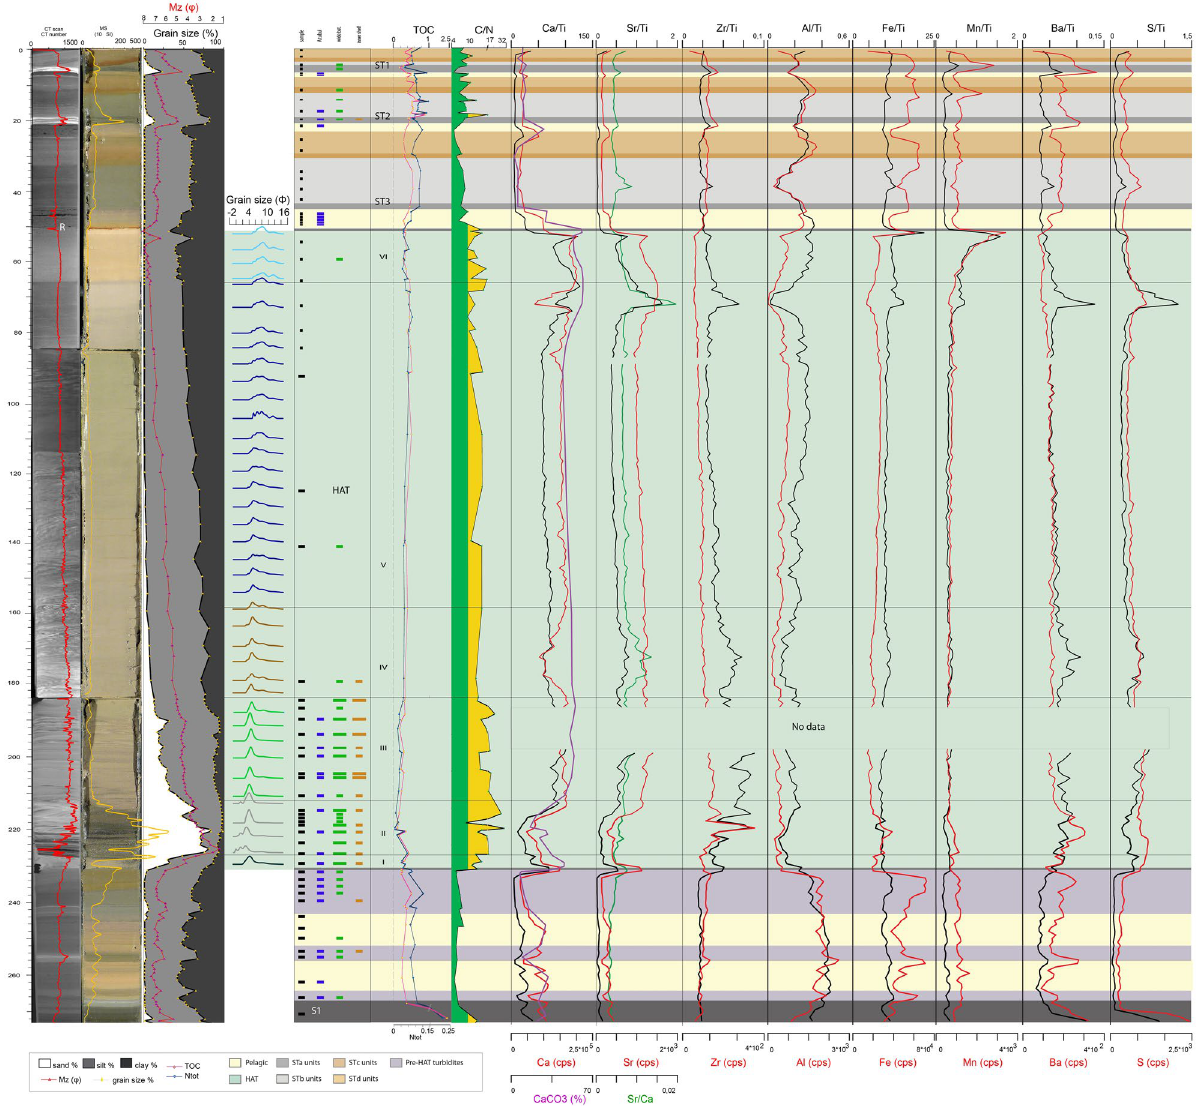
Figure 4. Log of core CALA-05. From left to right: CAT scan with HU (Hounsfield Unit), in red color, photograph with high-resolution magnetic susceptibility in yellow, grain size % with mean diameter in magenta, grain size modes in different colours for each sediment unit within the HAT, benthic foraminifera assemblages, sedimentary facies for ST1, ST2 and ST3 in different colors 4 , subdivision in individual HAT units (I-VI) in green and pelagic units identified by different colors, organic carbon data (TOC%, N tot , and C/N: green areas if C/N < 10, yellow areas if C/N > 10) and XRF data plot along the study sample. Yellow rectangle on the CAT scan image, represents 14 C dated samples (SM1). Benthic foraminiferal assemblages are grouped in three different classes: blue = abyssal species (mainly A. tubulosa); green = wide bathymetric ranges; brown = inner shelf (see Table 2, SM6 and SM7 for more details). Thin sample rectangles represent 0,5 cm thick samples. Thick sample rectangles represent 1 cm thick samples. Small coloured rectangles = rare specimens: < 25 specimens in 0.03 g of sample; large coloured rectangles = common specimens: > 25 specimens in 0.03 g of sample (see Table 2 for details on the bathymetric distribution). Identified seismo-turbidites (ST1, ST2 and ST3) with individual units (a, b, c and d) are indicated. XRF data were published in a previous paper 3